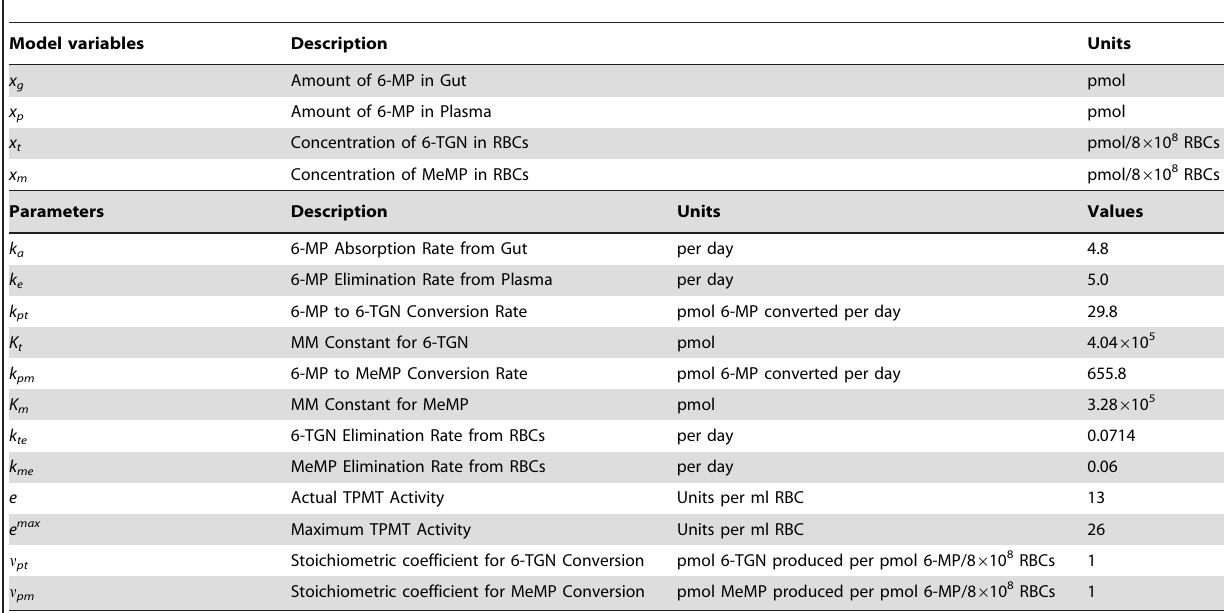
Table 1. Glossary of state variables and parameters for 6-MP model.